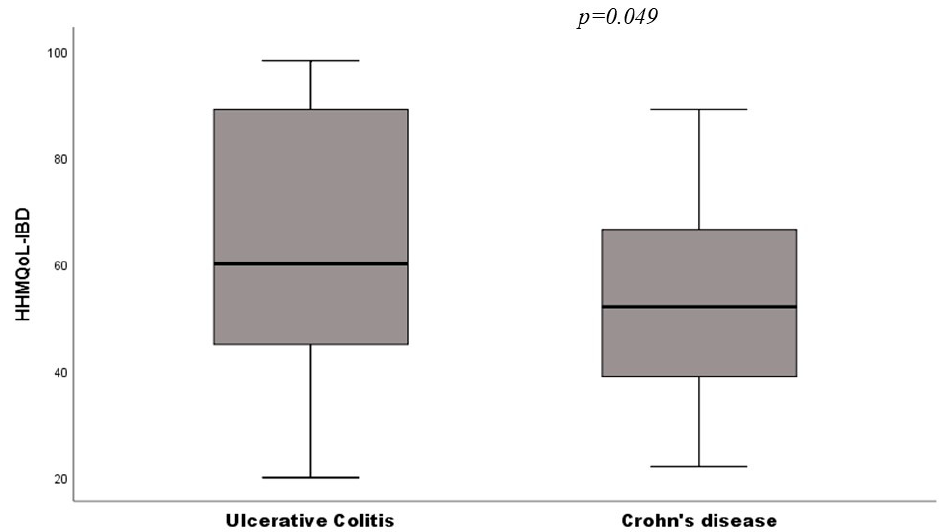
Figure 3. Means comparison of HHMQoL-IBD between cohabitants of patients with UC and